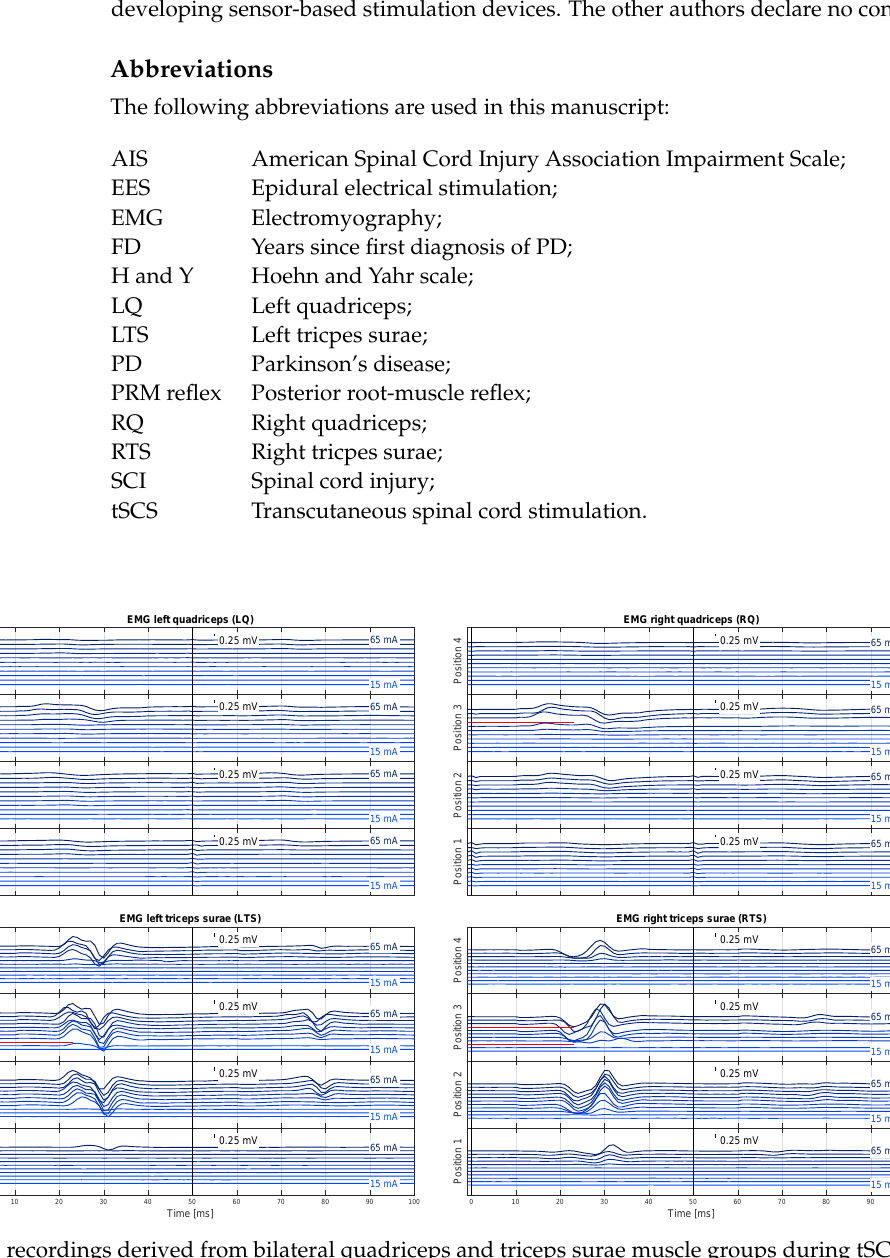
Figure A1. EMG recordings derived from bilateral quadriceps and triceps surae muscle groups during tSCS applied from different rostrocaudal electrode positions with double-stimuli of incremental amplitudes. Exemplary results derived from an individual with SCI, S2. Each trace averaged from up to three double stimuli per stimulation amplitude; blue-shaded values are stimulation